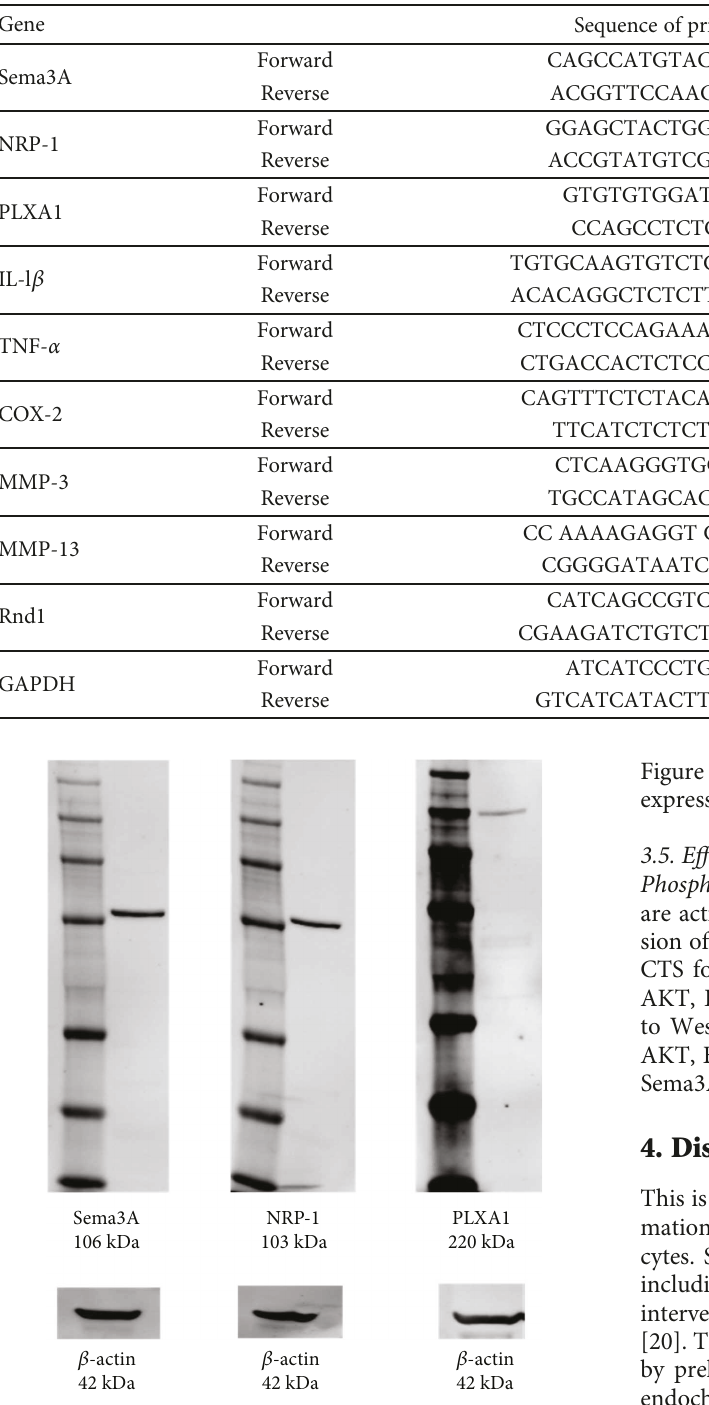
Figure 1: Expression of Sema3A, PLXA1, and NRP-1 in ATDC5 cells. Protein expression levels of Sema3A, PLXA1, and NRP-1 were determined in ATDC5 cells by Western blot analysis. β -actin was used as a loading